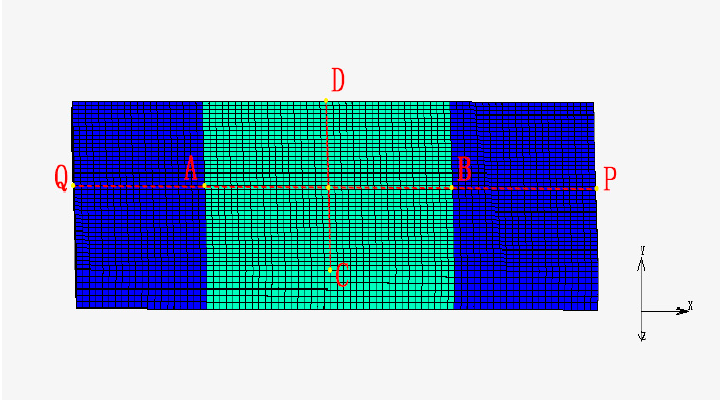
Figure 3. Schematic diagram of molybdenum plate model deformation area analysis.